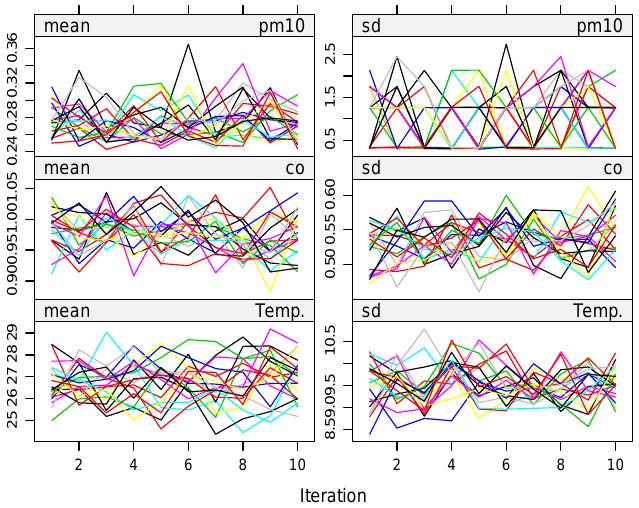
Figure A6. Inspecting the trace line convergence levels using an iterative Markov Chain–Monte Carlo type of algorithm with respect to the imputed means and standard deviations for PM 10 , CO , and temperature. These trace plots show the imputed value summaries for all imputed data sets with m = 20 after applying 10 iterations, in order to reach to the convergence level of stability.